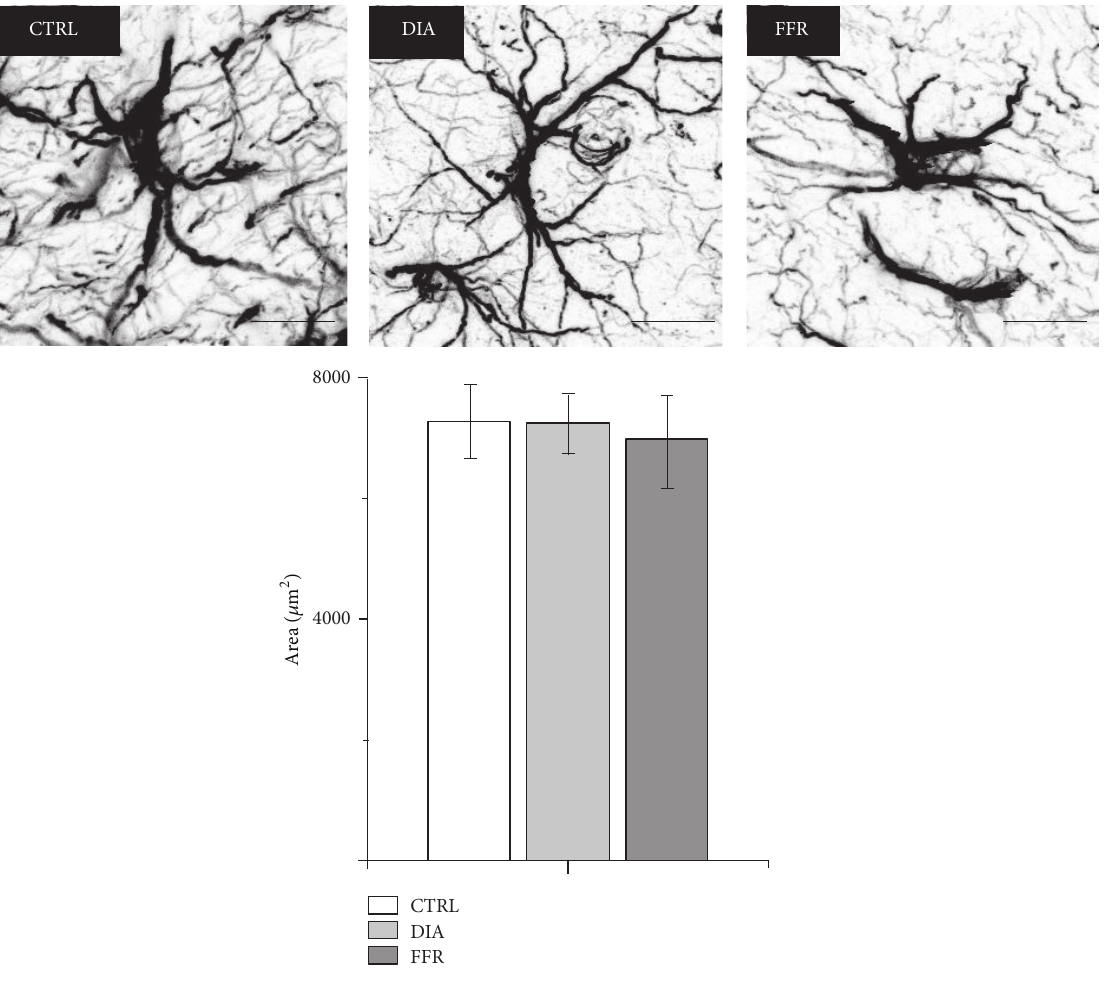
Figure 5: The average astrocyte area remains constant in DIA and FFR groups. The average area of astrocytes was estimated for control ( 𝑛 = 799 ), DIA ( 𝑛 = 1201 ), and FFR ( 𝑛 = 806 ) groups. No significant changes were observed. Scale bar = 10 𝜇 m. Data are mean ±